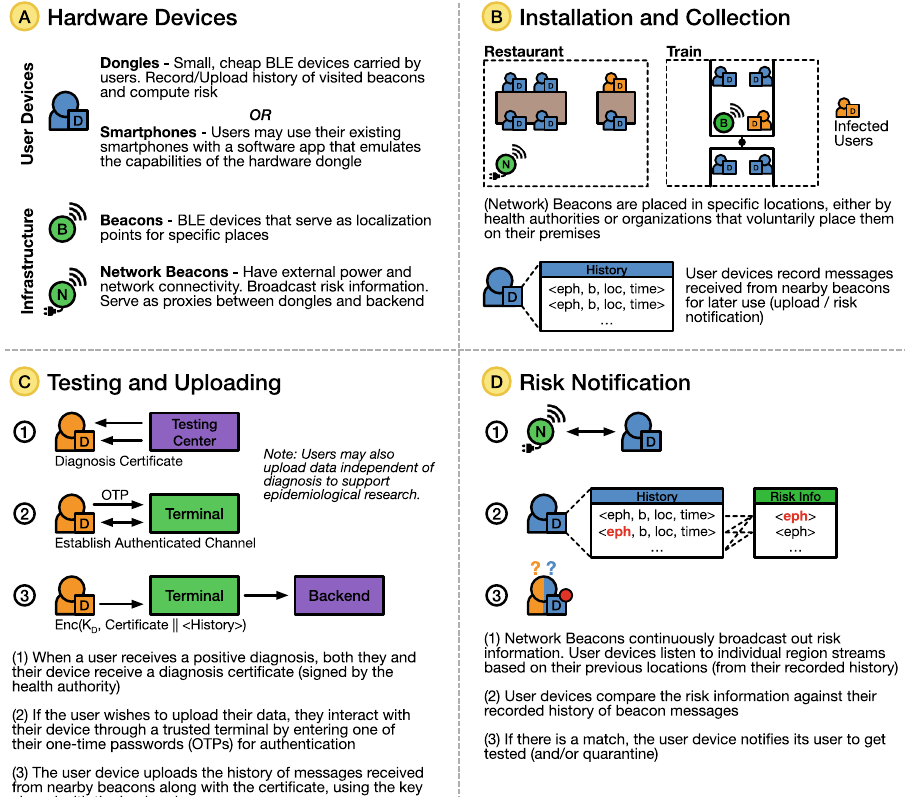
Figure 5. PanCast’s hardware devices, installation and collection, testing and uploading, and risk